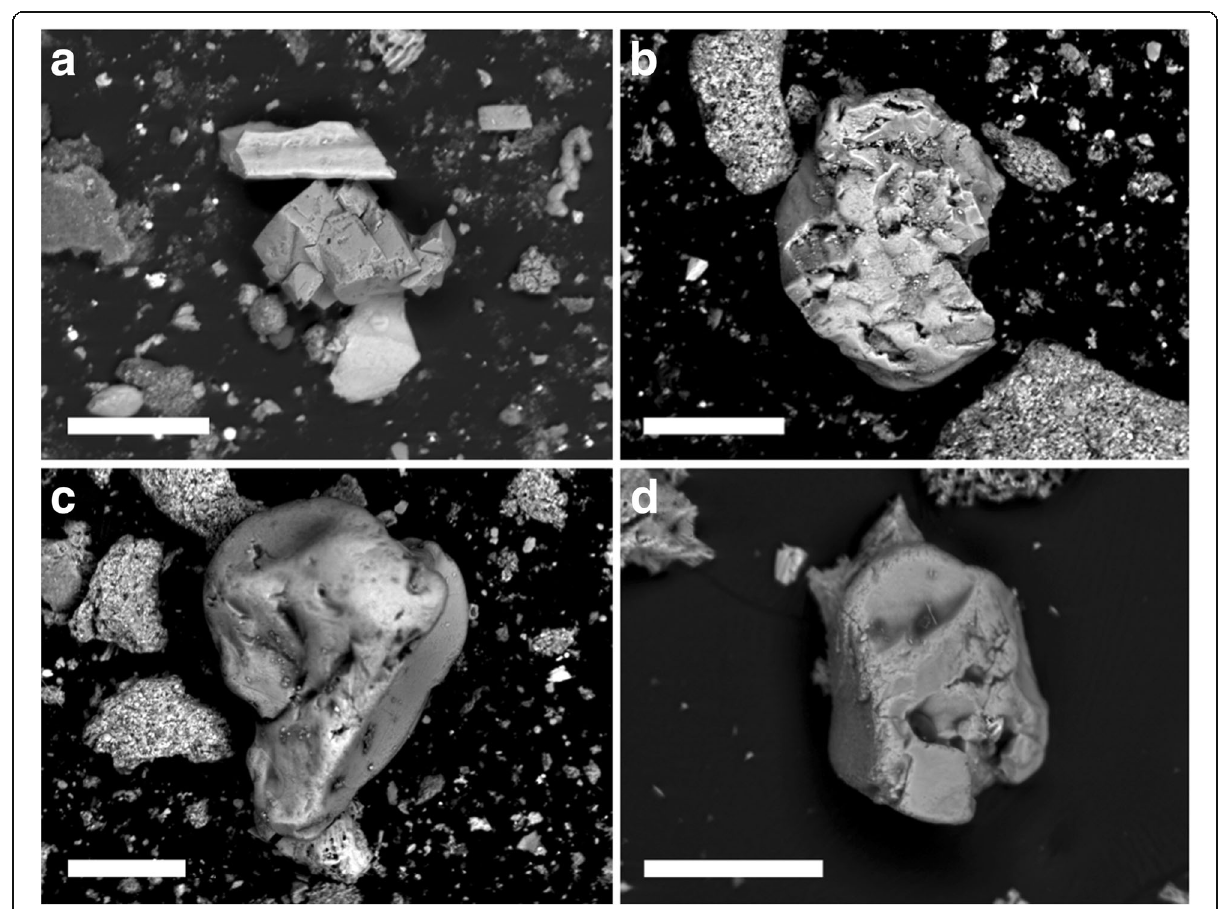
Fig. 5 Dust grains in various samples uncovered by scanning electron microscopy. SEM images showing selected dolomite ( a ) and quartz ( b – d ) grains. The dust particles are recognised because of their abraded surfaces; scale bar = 100 μ